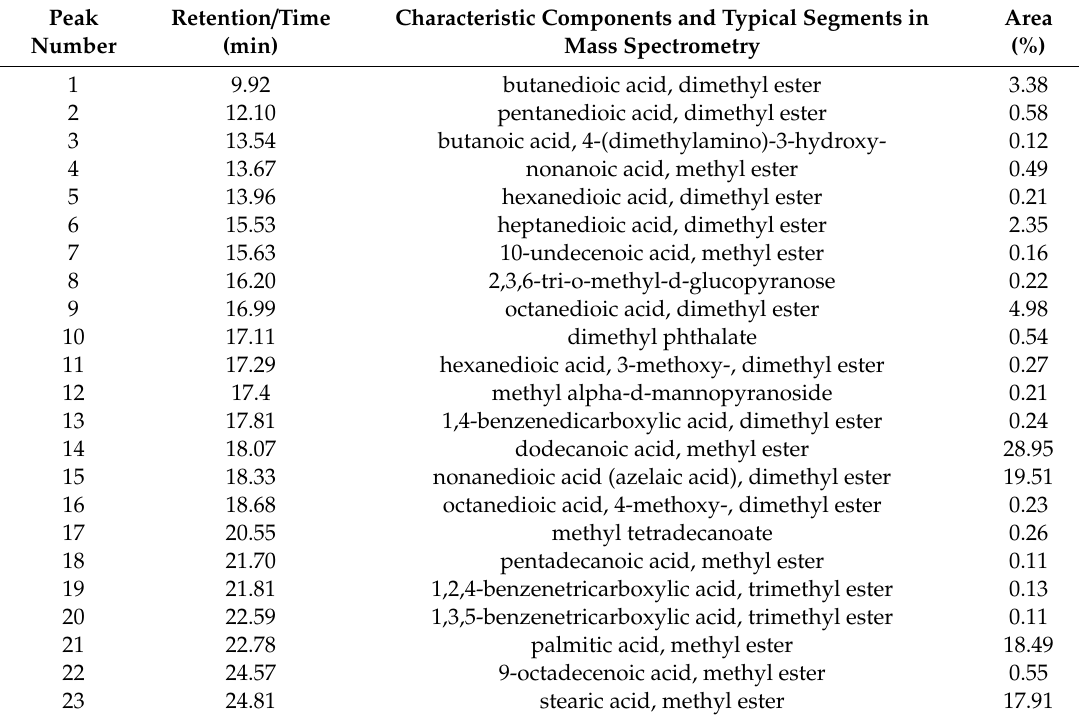
Figure 9. Total ion chromatography of mortar samples. Table 5. A list of compounds identified by total ion chromatography of mortar obtained by pyrolysis–gas chromatography–mass